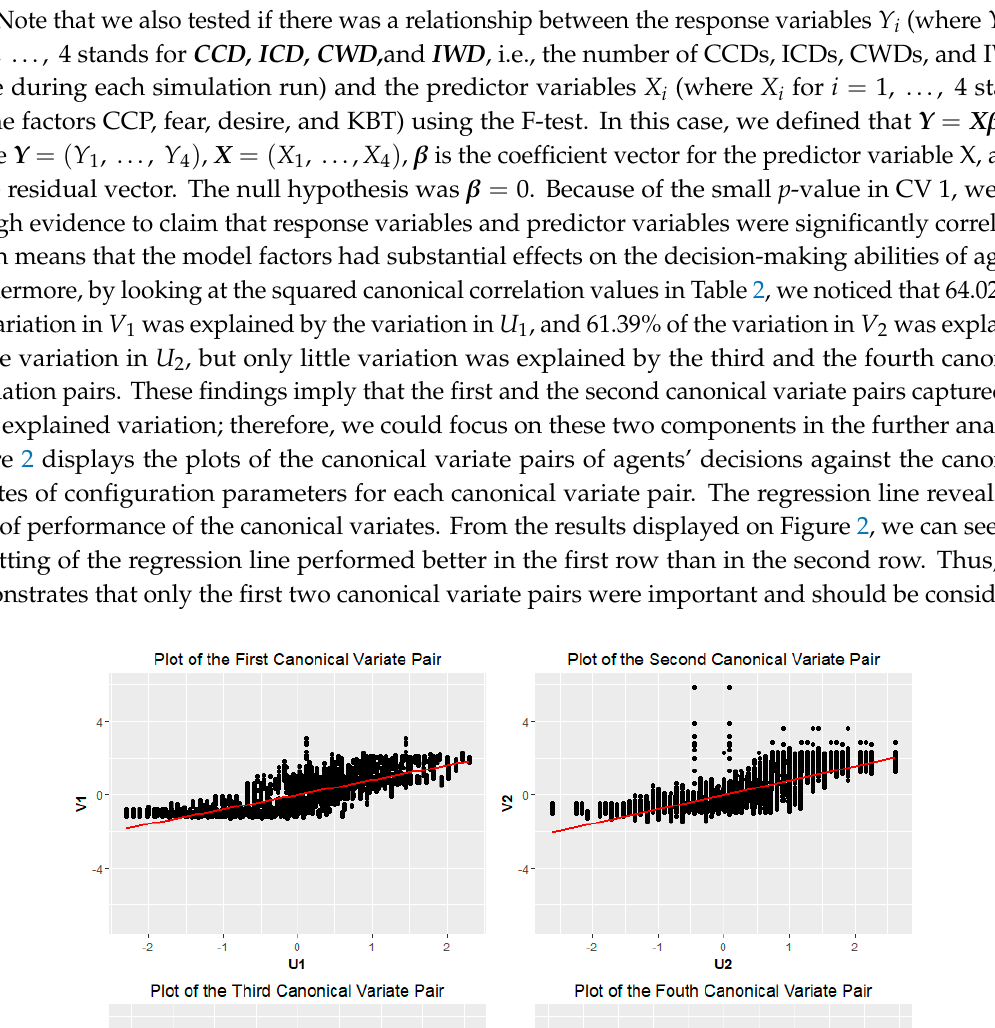
Table 2. The F-test results for canonical correlations of each canonical variate pair. F-Test for Canonical Correlations